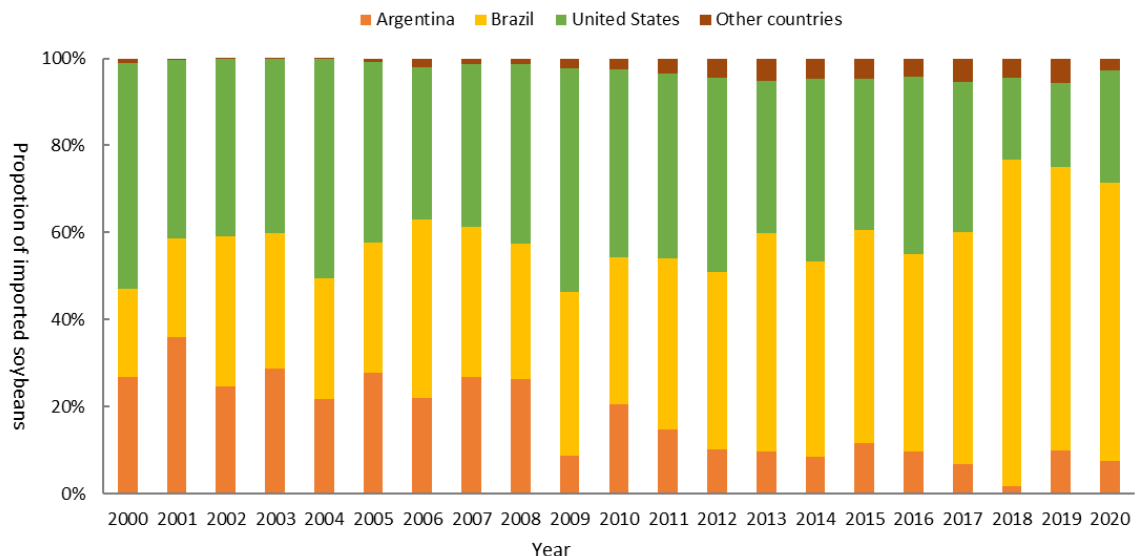
Figure 5. Proportion of China’s soybean imports from 2000 to 2020 ( data source: FAO).